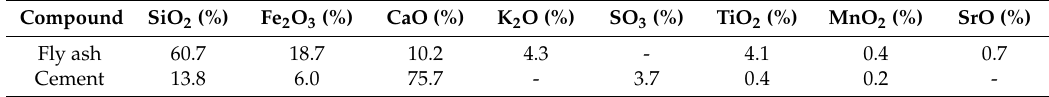
Table 1. Chemical Composition of Fly ash and Cement.